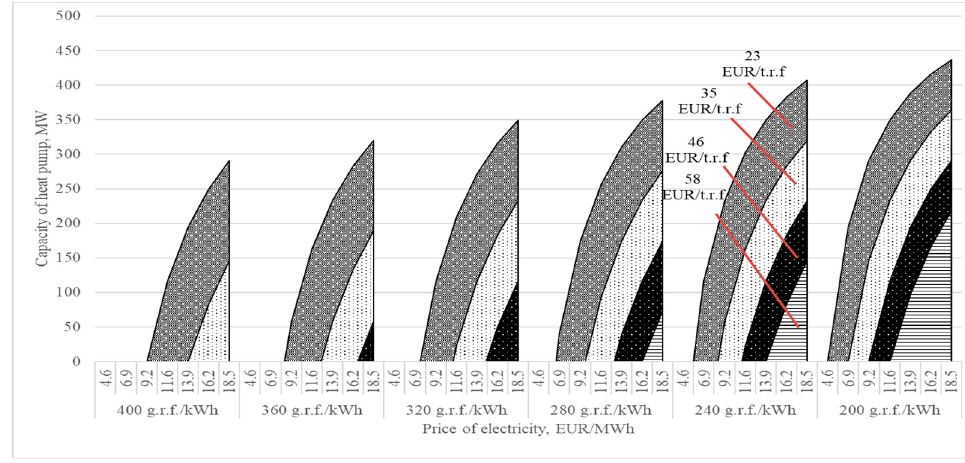
Figure 5. The range of permissible HP capacity depending on the efficiency of the TPP.